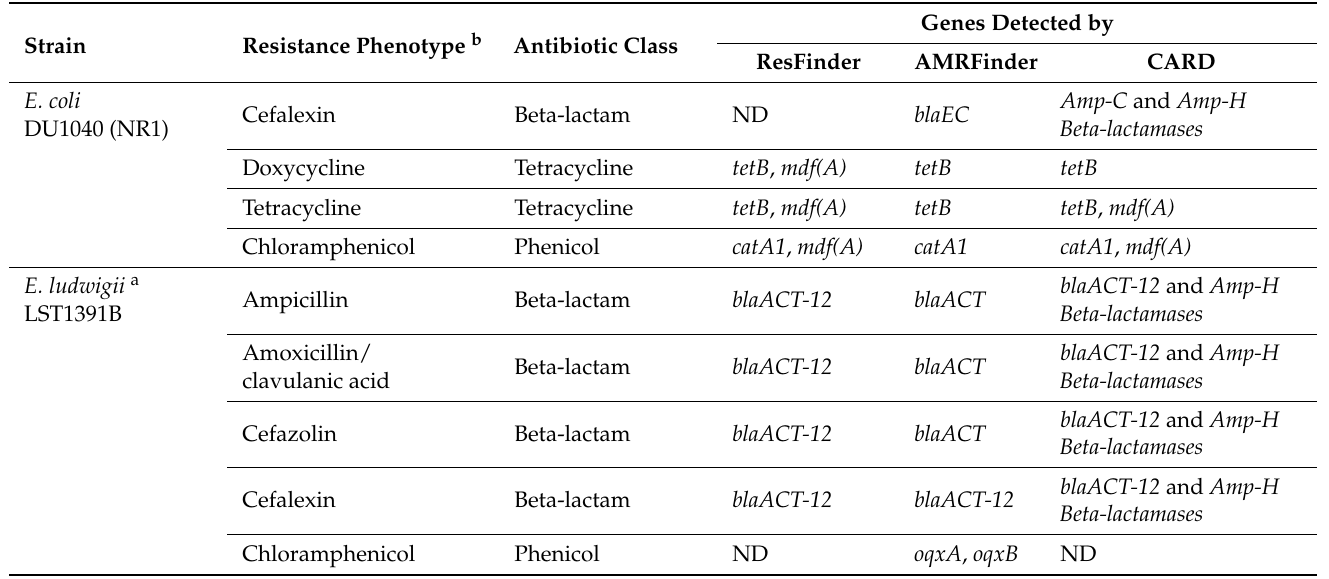
Table 4. Correspondence of experimentally determined resistance phenotypes versus AMR genes detected in total genomic